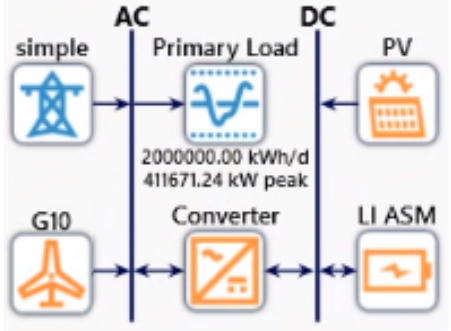
Figure 8. Schematic presentation of the developed model.